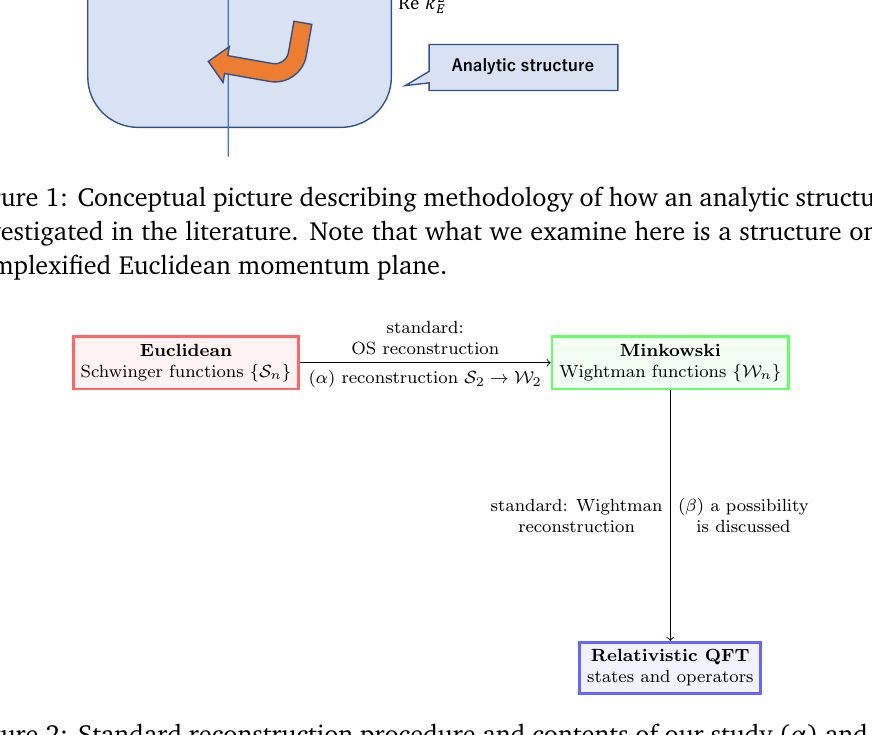
Figure 2: Standard reconstruction procedure and contents of our study ( α ) and ( β